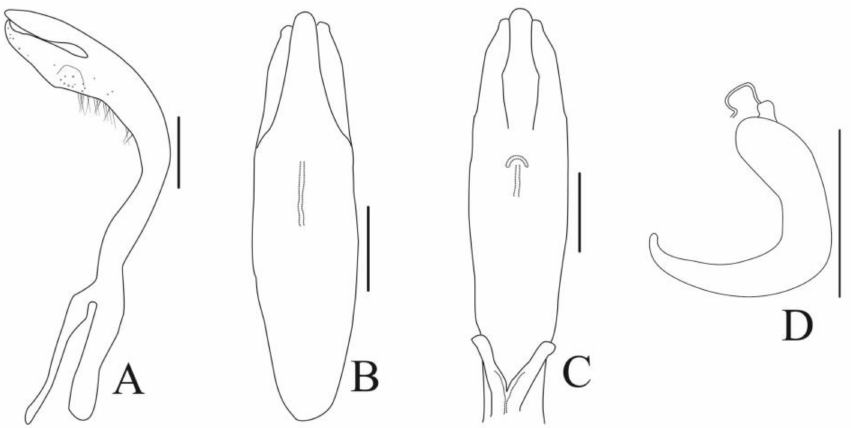
Figure 3. Cryptocephalus ( Burlinius ) longchiensis Duan & Zhou, sp. nov.: ( A ) lateral view of aedeagus; ( B ) dorsal view of aedeagus; ( C ) ventral view of aedeagus; ( D ) spermatheca. (Scale bars: 0.2 mm). Type of locality. is China: Sichuan Province: E’meishan City, Longchi